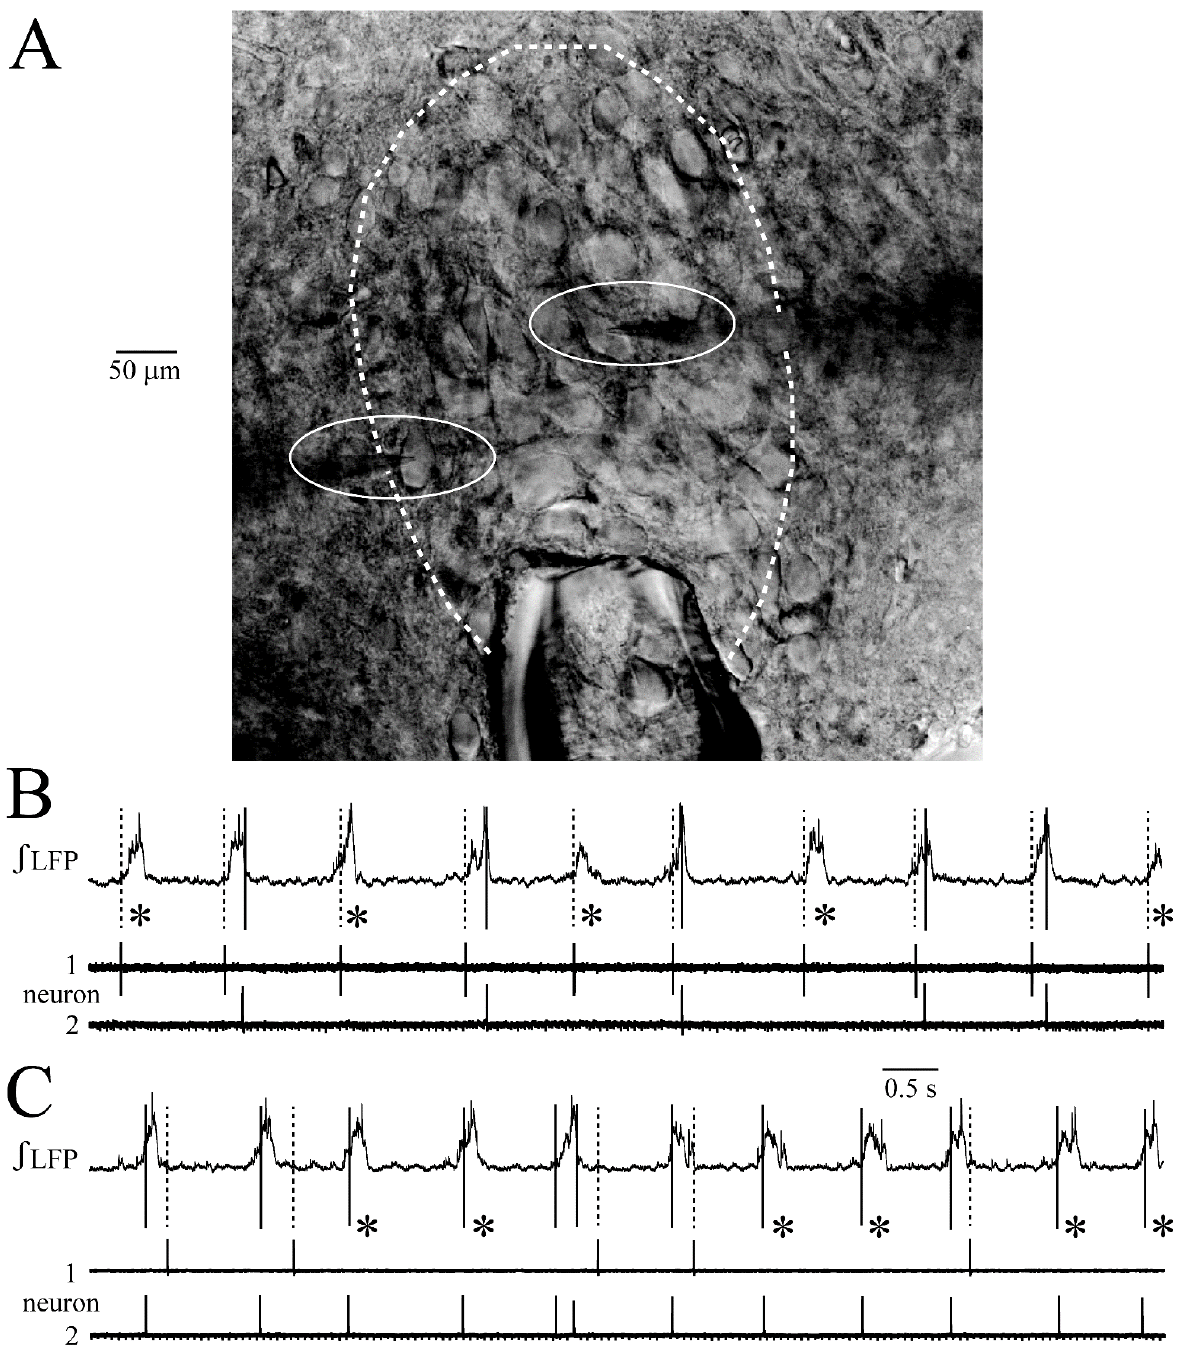
Figure 2. LC neuron spike jitter. ( A ) Photograph of the LC (outlined by white dashed line) with the suction electrode positioned close to the rim of the neuron somata area next to the 4th ventricle (not shown) while two patch electrodes (outlined by solid white lines) were positioned on the somata of LC neurons for spike recording. ( B , C ) Examples for such recording in two slices. In both examples, with ( B ) corresponding to the photo in ( A ), one neuron fires a single spike during each LFP whereas the other cell shows spike failures (see asterisks). The LFP comprises mostly discharge from 3–10 neurons (see Results). Thus, random spike failures cause differences in LFP amplitude, whereas jitter regarding the time point of discharge during the LFP [see distance between solid and dotted lines and compare (Figure 7D)] explains LFP duration and shape variability.